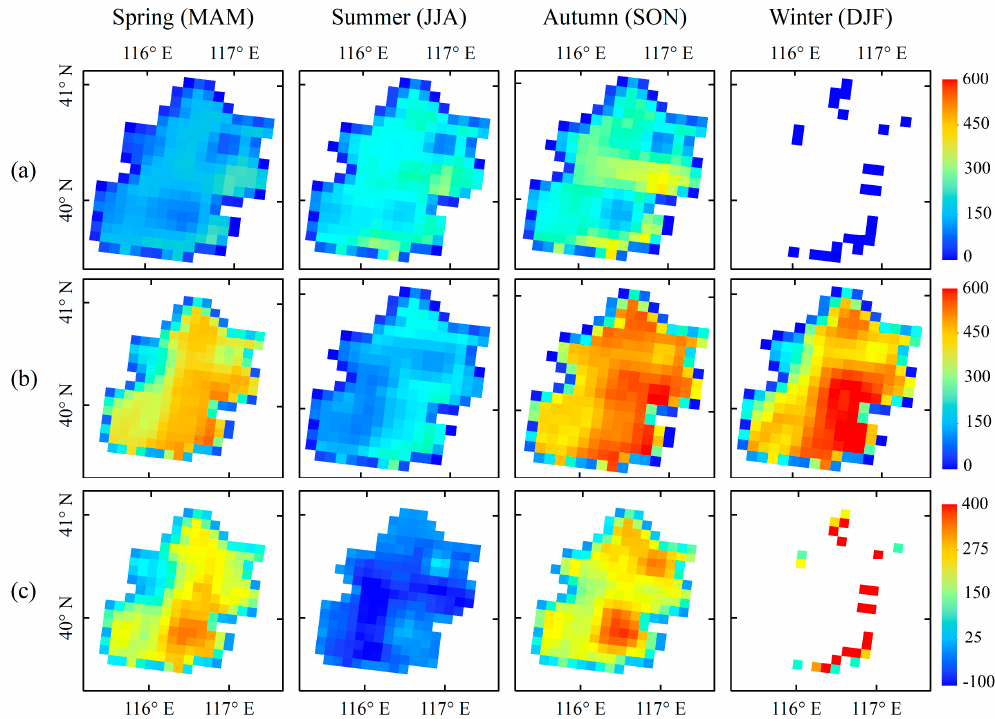
Figure 6. The number of days for the effective retrieval (NE) of ( a ) MODIS-Aqua C6.1 DT and ( b ) MODIS-Aqua C6.1 DB; and ( c ) the seasonal number differences (DB_NE–DT_NE) between the DT and DB from July 2002 to December